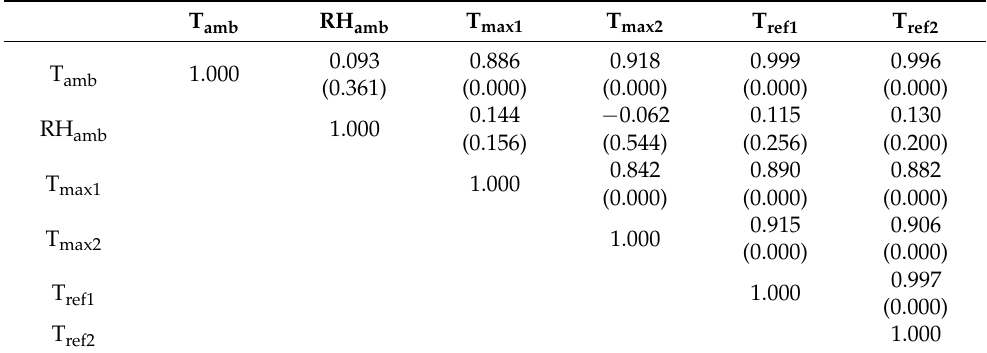
Table 2. Pearson’s correlation matrix.